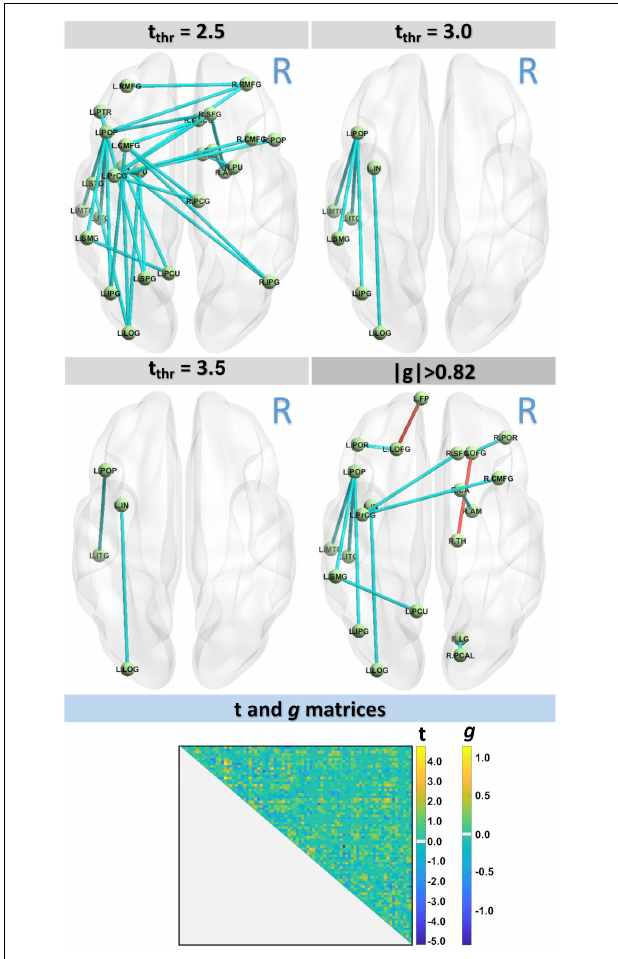
FIGURE 2 | Connectivity analysis with three t -values thresholds, t thr = 2.5, t thr = 3.0, and t thr = 3.5, showed lower connectivity in MCI group. Results were also confirmed by the effect-size analysis.